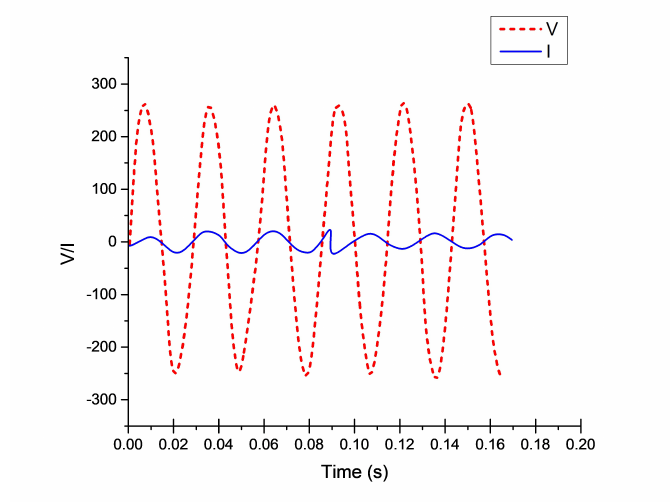
Figure 16. Bidirectional power flow waveform of the current and